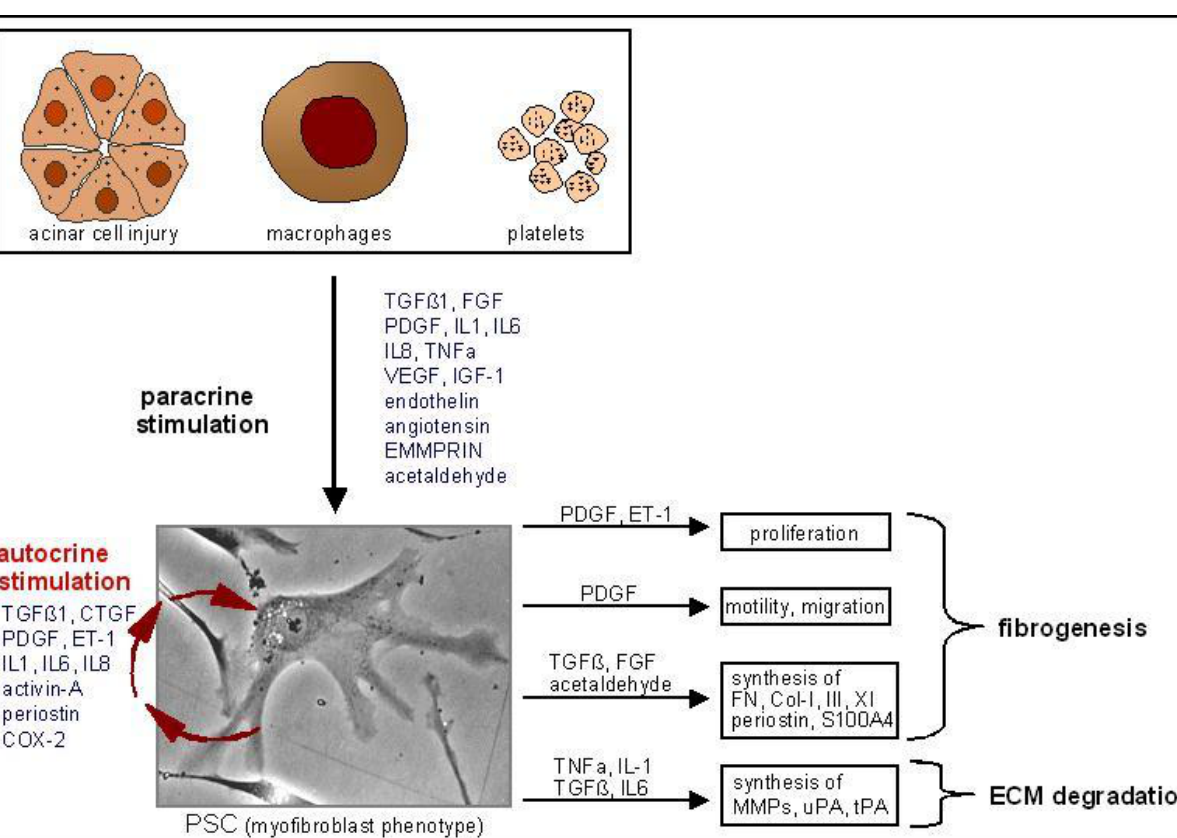
Figure 3. Paracrine and autocrine stimulation of activated pancreatic stellate cells in culture. Injured acinar cells, activated inflammatory cells, aggregating platelets, ethanol and acetaldehyde stimulate PSC proliferation, matrix- and MMP-synthesis and PSC motility. Via autocrine stimulatory loops PSC proliferation and ECM-synthesis are also stimulated. AM, adrenomedullin; SDF-1, stromal cell-derived factor-1; ET-1,